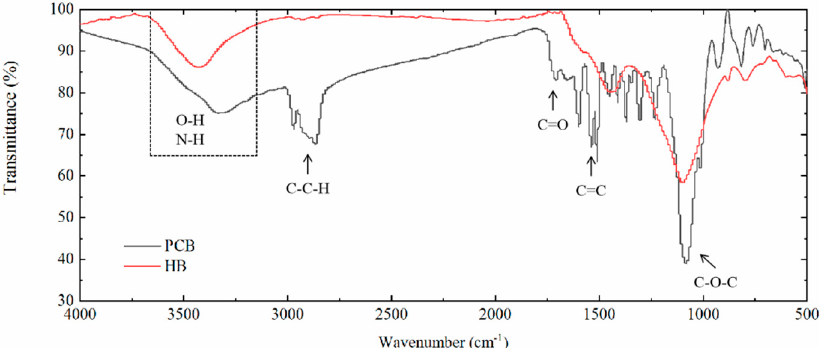
Figure 2. Fourier transform infrared (FTIR) spectra of PCB and hardwood biochar (HB).